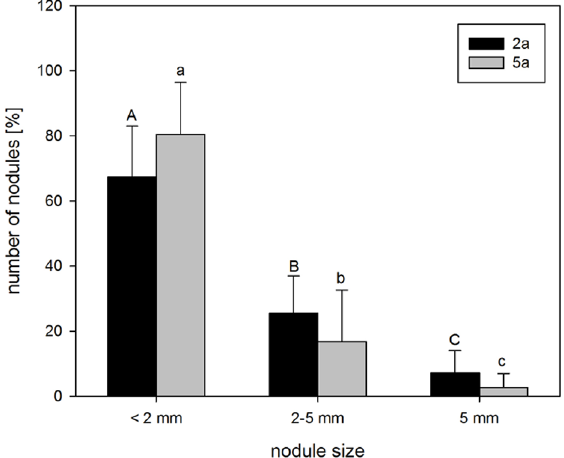
Fig. 2. Copy numbers per nodule of the functional gene nifH . Gene abundances were measured in small and medium sized nodules from the 2a and the 5a site ( n = 3, error bars represent standard